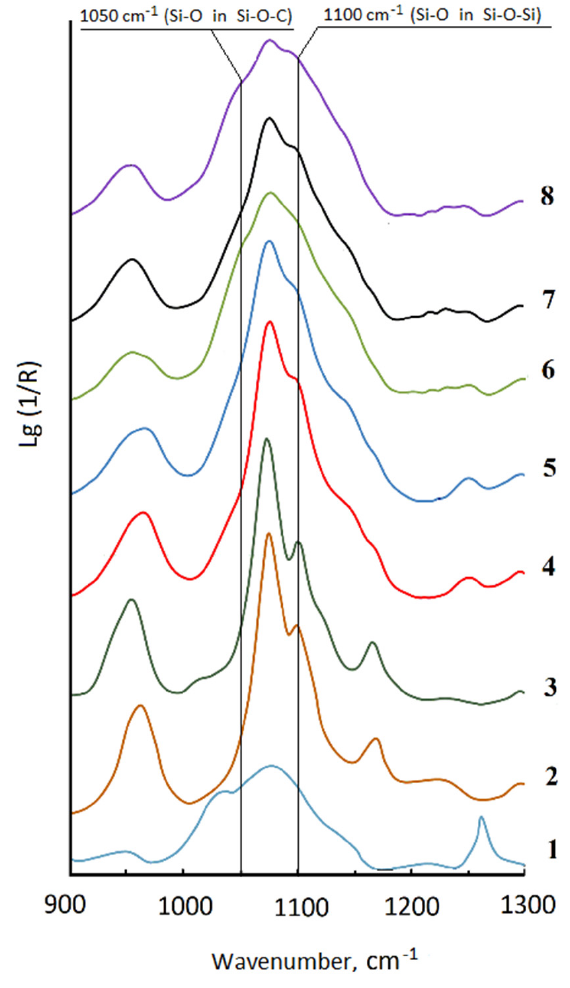
Figure 1. FTIR spectra of PEO (1), TEOS (2), AGM (3), PEOASiP (4), ASiP–AGM-10 (5), ASiP– AGM-50 (6), ASiP–AGM-80 (7) and ASiP–AGM-100 (8).